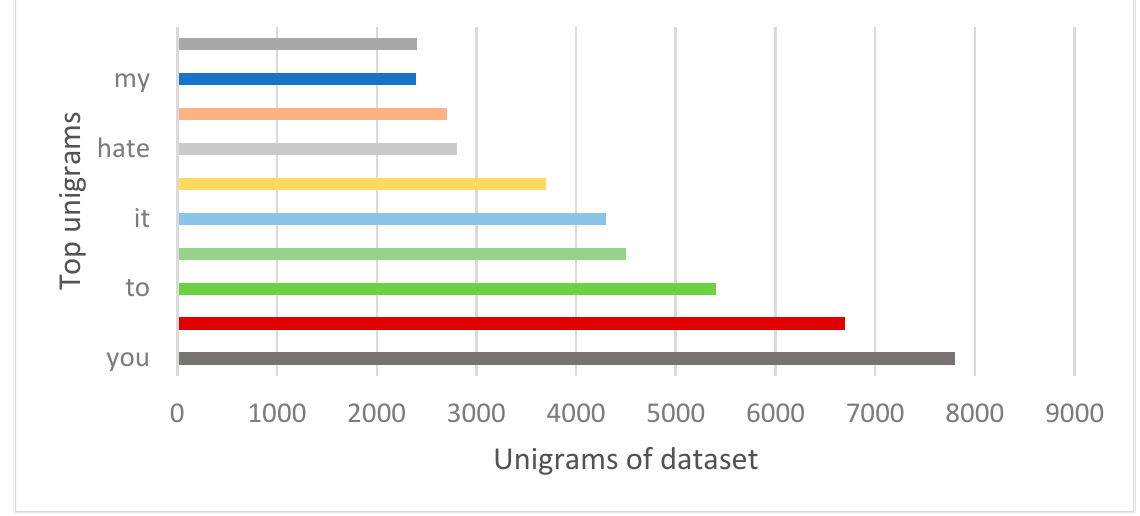
Figure 8. Unigrams of Dataset.